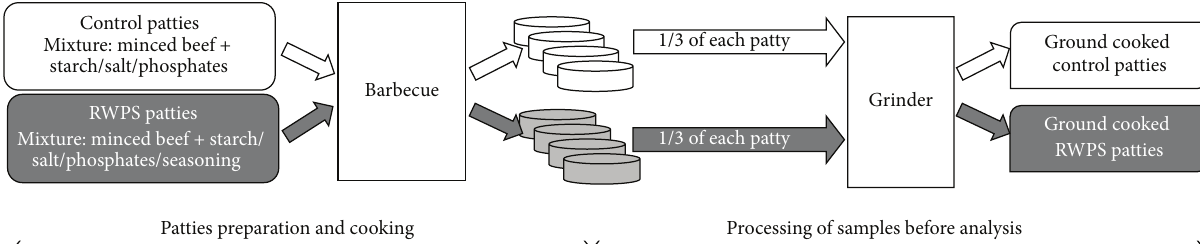
Figure 1: Scheme of sampling